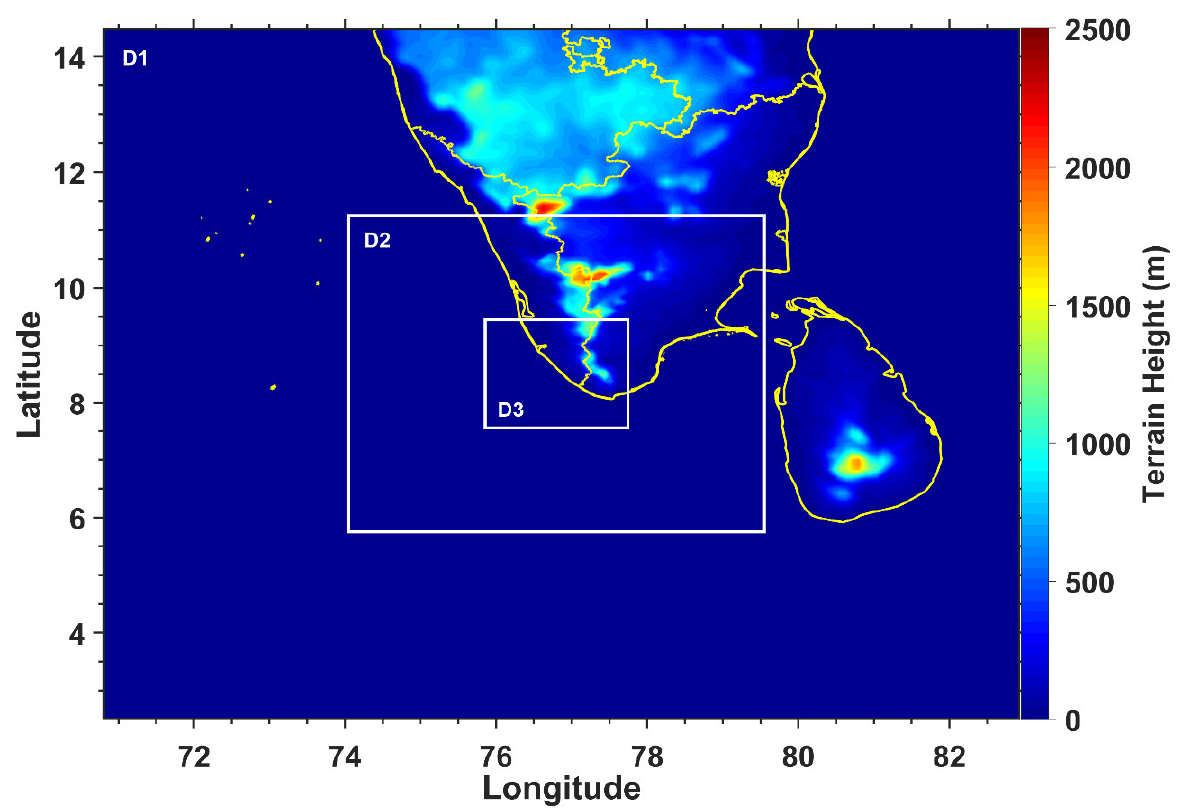
Figure 4. Nested domain configuration used for the simulation of the thunderstorm on 13 May 2018. Grid resolutions of the three domains (D1, D2 and D3) are 9 km, 3 km and 1 km, respectively. Colour bar shows the terrain height (m) over the simulation region.